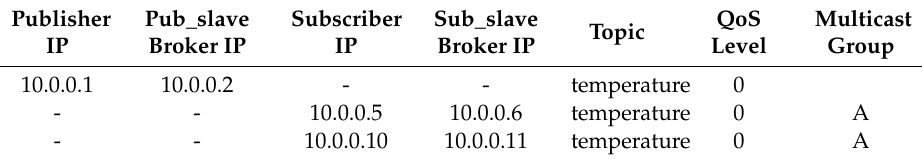
Figure 6. Flow of edge information and connection message path of DM-MQTT in edge networks. Table 2. Group table created by MQTT group management module.